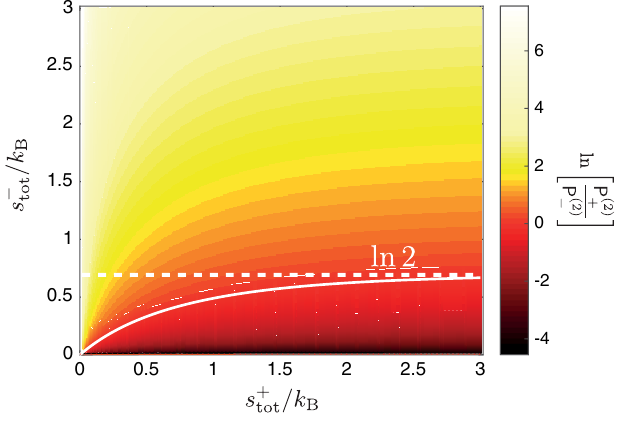
2 Þ = P ð 2 Þ − (cid:2) þ and s þ , obtained from tot tot k → þ ∞ (white ln 2 for s þ B tot ¼ tot